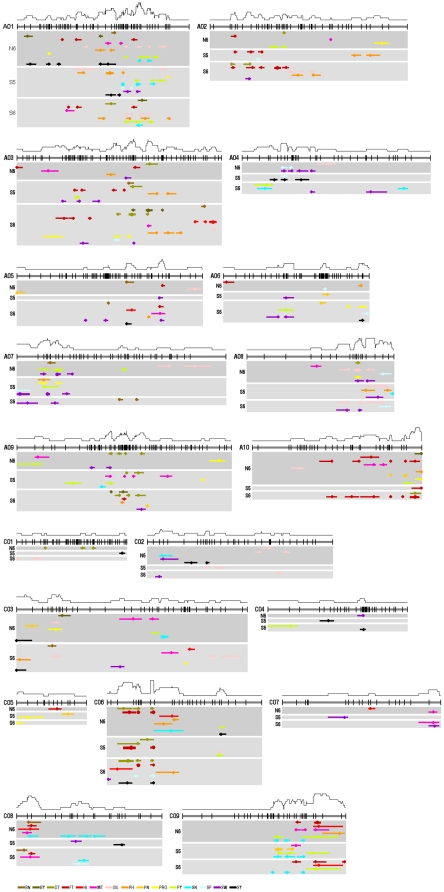
The genome-wide distribution of QTL identified in reconstructed F2 population and three environments for 15 yield-correlated traits.A total of 390 QTL were identified in reconstructed F2 population and three environments for 15 yield-correlated traits. The 19 linkage groups of TNDH linkage map are shown as a thick black line with vertical lines to indicate the position of the molecular markers, and the labels on the left represent their name (A genome: A01-A10; C genome: C01-C09). Under the linkage group lines, the QTL are drawn with horizontal bars where their lengths show the confidence interval, the circle indicates the peak position and the width of the QTL line imply the magnitude of their phenotypic variance (R
2<10%; 10%≤R
2<20%; 20%≤R
2<30%), and the labels on the left represent the codes of the three environments (N6, S5, S6) in which these QTL was identified. Above these linkage group lines, the black curves indicate the frequency of distribution of QTL. At the bottom of the figure, the horizontal lines of different colour indicate the different traits, and the letters on the right represent their abbreviations (see MATERIALS AND METHODS).